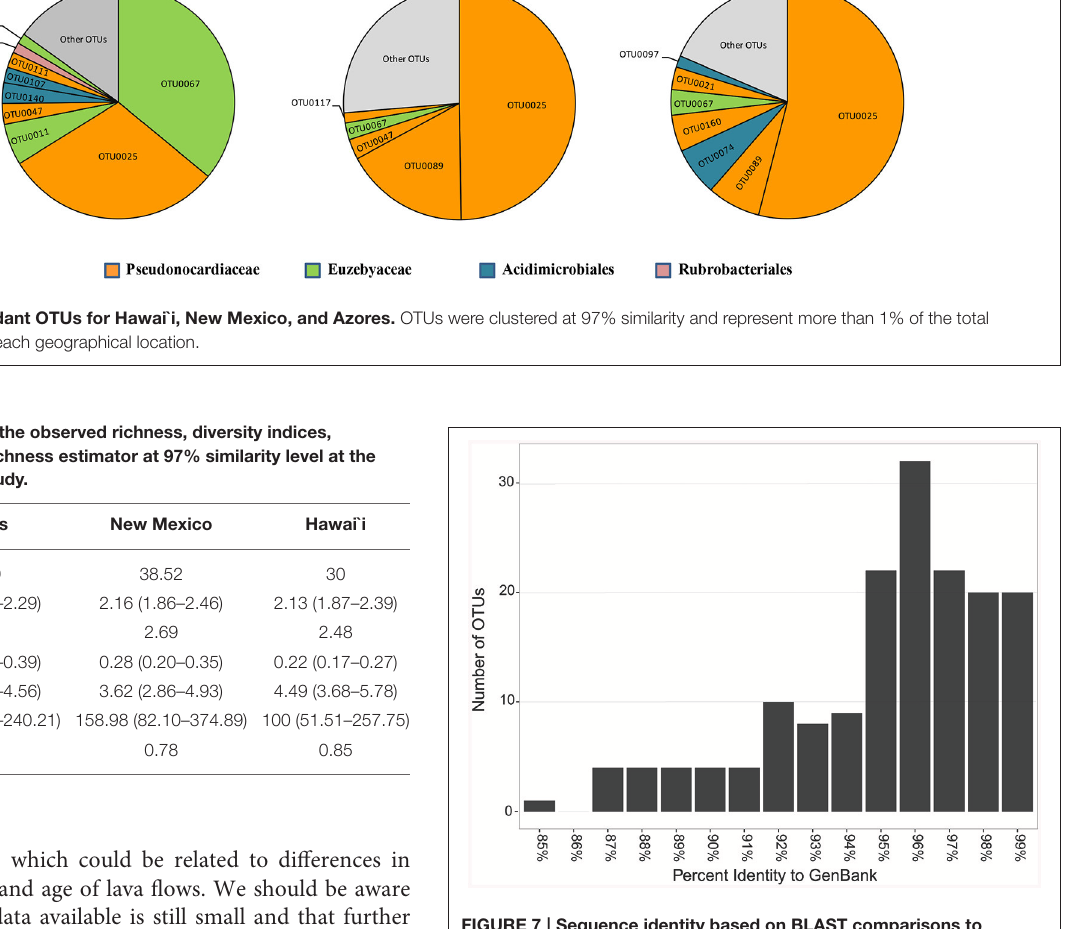
relationship between the sequences and occurrence of